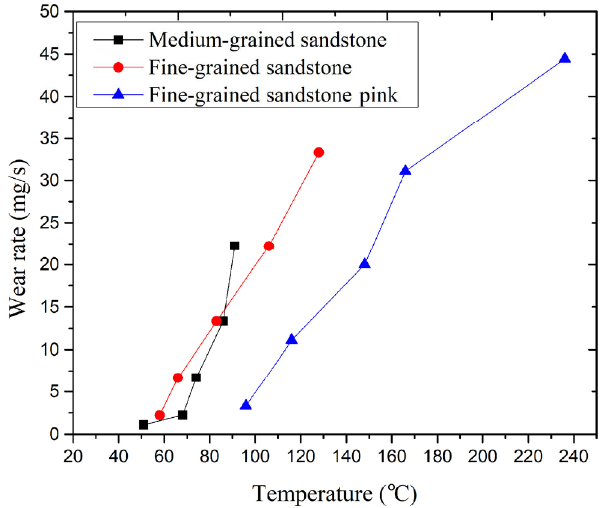
Fig. 6 Effect of bit-rock interface temperature on the wear rate of the drill bit.